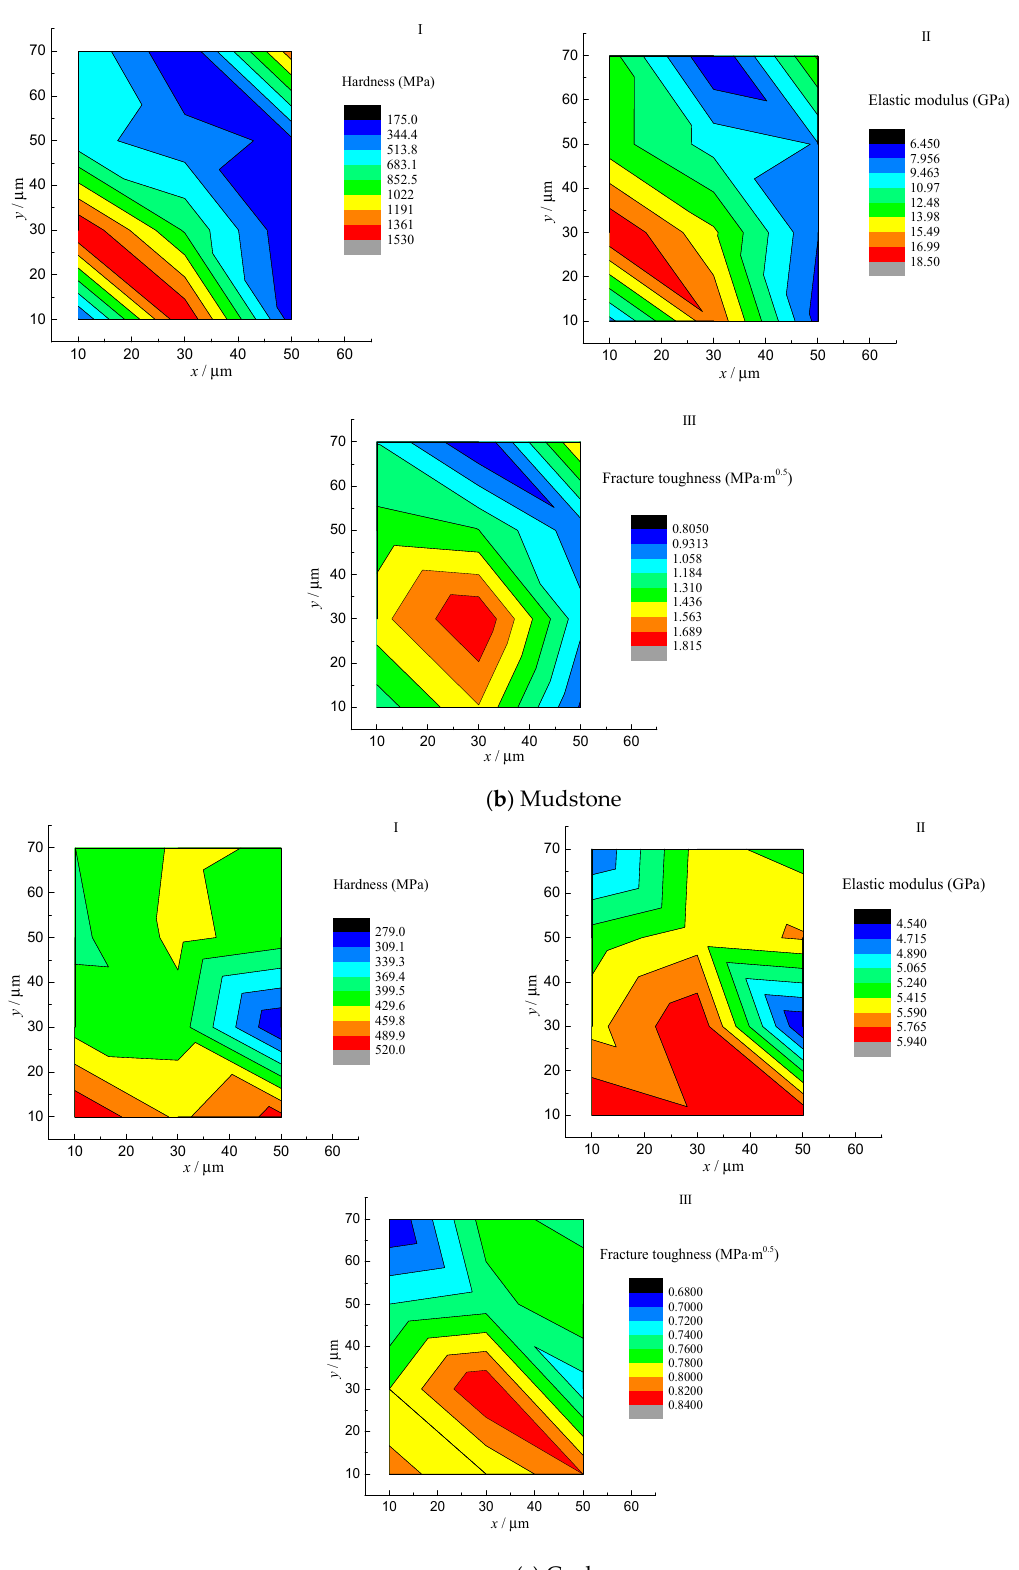
Figure 12. Heterogeneity maps of ( a ) shale ( b ) mudstone and ( c ) coal. In Figure 12, maps labelled Ⅰ , Ⅱ , Ⅲ are hardness, elastic modulus and fracture toughness, respectively. It can be seen that different locations possess different micromechanical parameters.